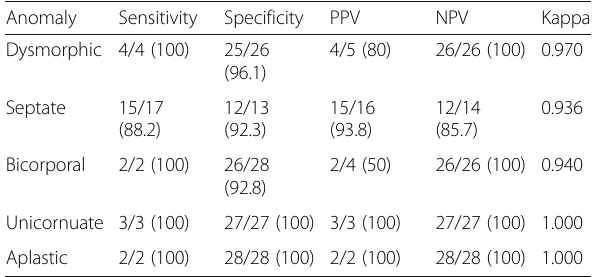
Table 4 Accuracy of 3DTVS compared with MRI regarding diagnosis of Mullerian duct abnormalities of the present